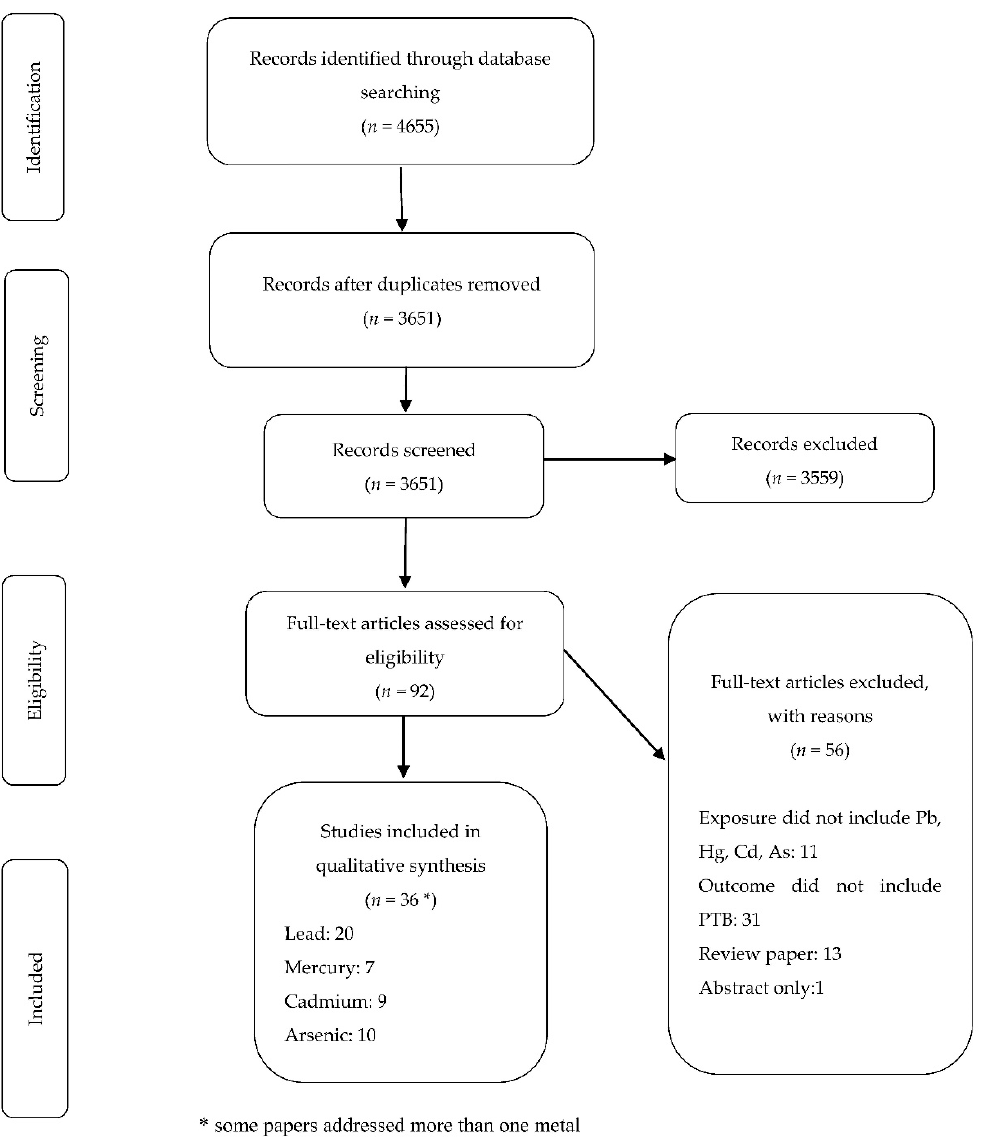
Figure 1. PRISMA flow diagram of selection of papers and data extraction process.